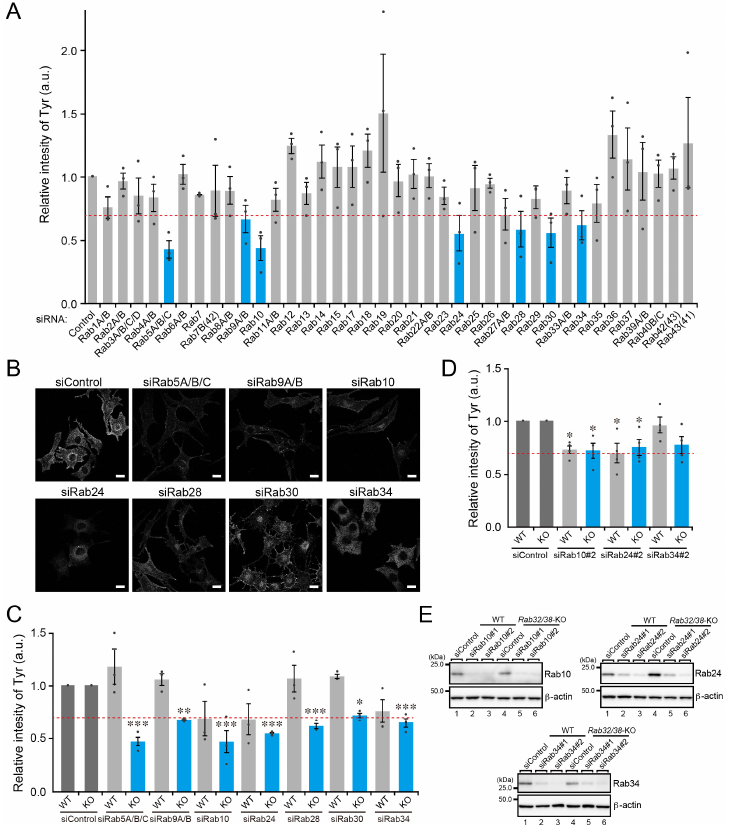
Figure 6. Comprehensive screening for Rabs whose KD resulted in a reduction in Tyr signals in Rab32/38 -KO B16-F1 cells. ( A ) Relative intensity of Tyr in Rab32/38 -KO cells transfected with control siRNA or siRNA against each Rab subfamily was determined by a quantitative immunofluorescence analysis. Error bars indicate the SEM of the data obtained in three independent experiments ( n > 10 cells in each experiment). The broken red line indicates a 30% reduction in Tyr signals. The blue bars represent the seven candidate Rabs whose KD resulted in a more than 30% reduction in Tyr signals in comparison with the control siRNA. KD of these candidate Rabs was confirmed by RT-PCR analysis (see Figure S2). ( B ) Typical images of Tyr in the candidate Rab-KD cells shown in ( A ). Scale bars, 20 µ m. ( C ) Relative intensity of Tyr in WT cells (light gray bars) and Rab32/38 -KO B16-F1 cells (blue bars) transfected with control siRNA or siRNA against each candidate Rab shown in ( A ), as determined by quantitative immunofluorescence analysis. Error bars indicate the SEM of the data obtained in three independent experiments ( n > 10 cells for each experiment). The broken red line indicates the 30% reduction of Tyr signals. *, p < 0.05; **, p < 0.01; ***, p < 0.001 in comparison with the results obtained with the control siRNA (Dunnett’s test). ( D ) Relative intensity of Tyr in WT cells (light gray bars) and Rab32/38 -KO B16-F1 cells (blue bars) transfected with control siRNA or siRNA#2 against Rab10, Rab24, and Rab34. Error bars indicate the SEM of the data obtained in four independent experiments ( n > 20 cells for each experiment). The broken red line indicates the 30% reduction of Tyr signals. *, p < 0.05 in comparison with the results obtained with the control siRNA (Dunnett’s test). ( E ) KD efficiency of siRNAs toward Rab10, Rab24, and Rab30 as revealed by immunoblotting with the specific antibodies